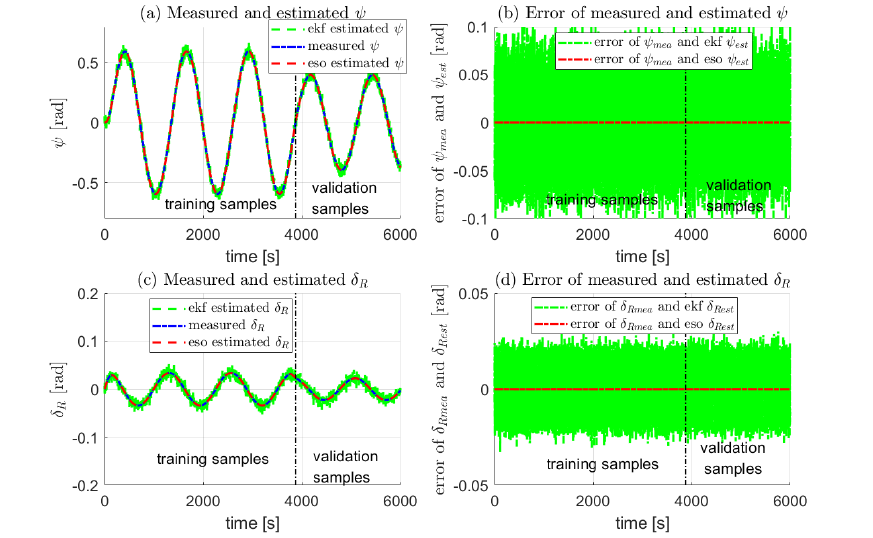
Figure 3. Measurements and estimates of heading angle ψ and rudder angle δ R of the cargo vessel. The data on the left side of the black dotted line are training samples and on the right side are validation samples.